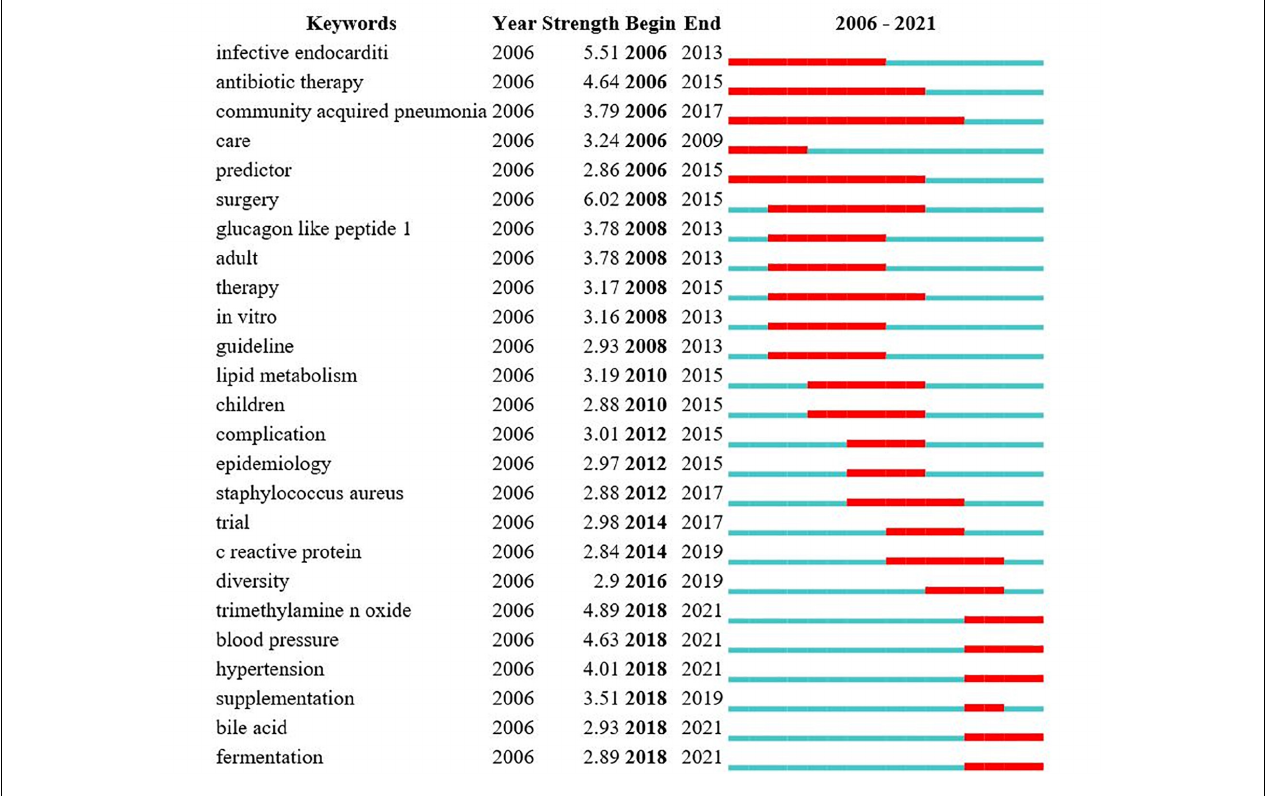
shed light on the possible link between heart failure and gut microbiota around high-fat diet (26), phosphatidylcholine (17, 27), cholesterol, and high-intensity